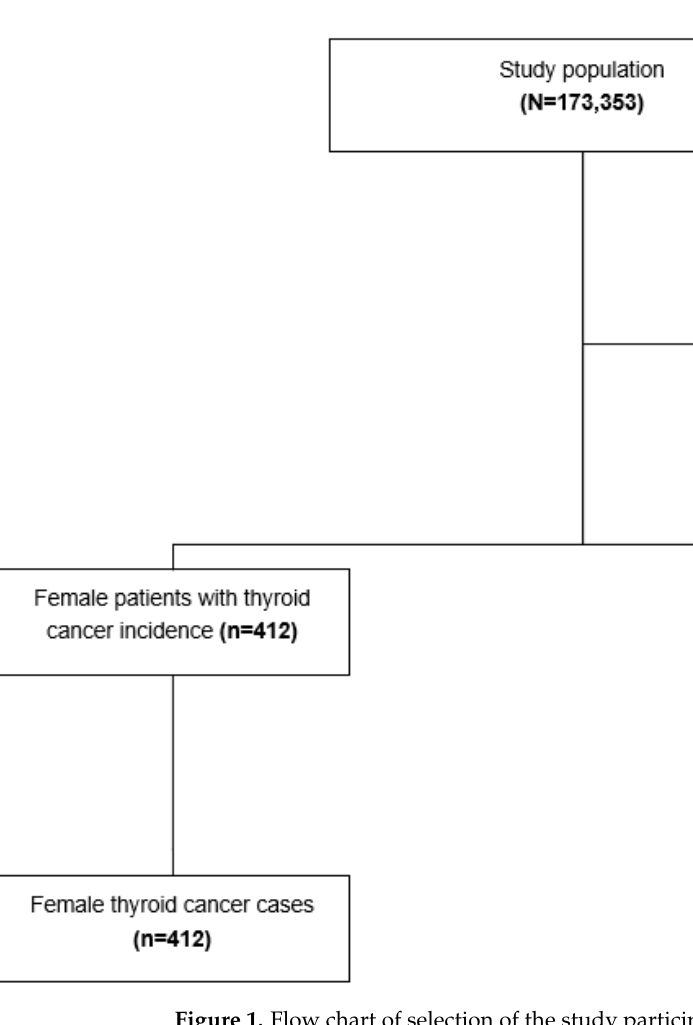
Figure 1. Flow chart of selection of the study participants. * Excluded male participants because the number of male thyroid cancer cases was too small.